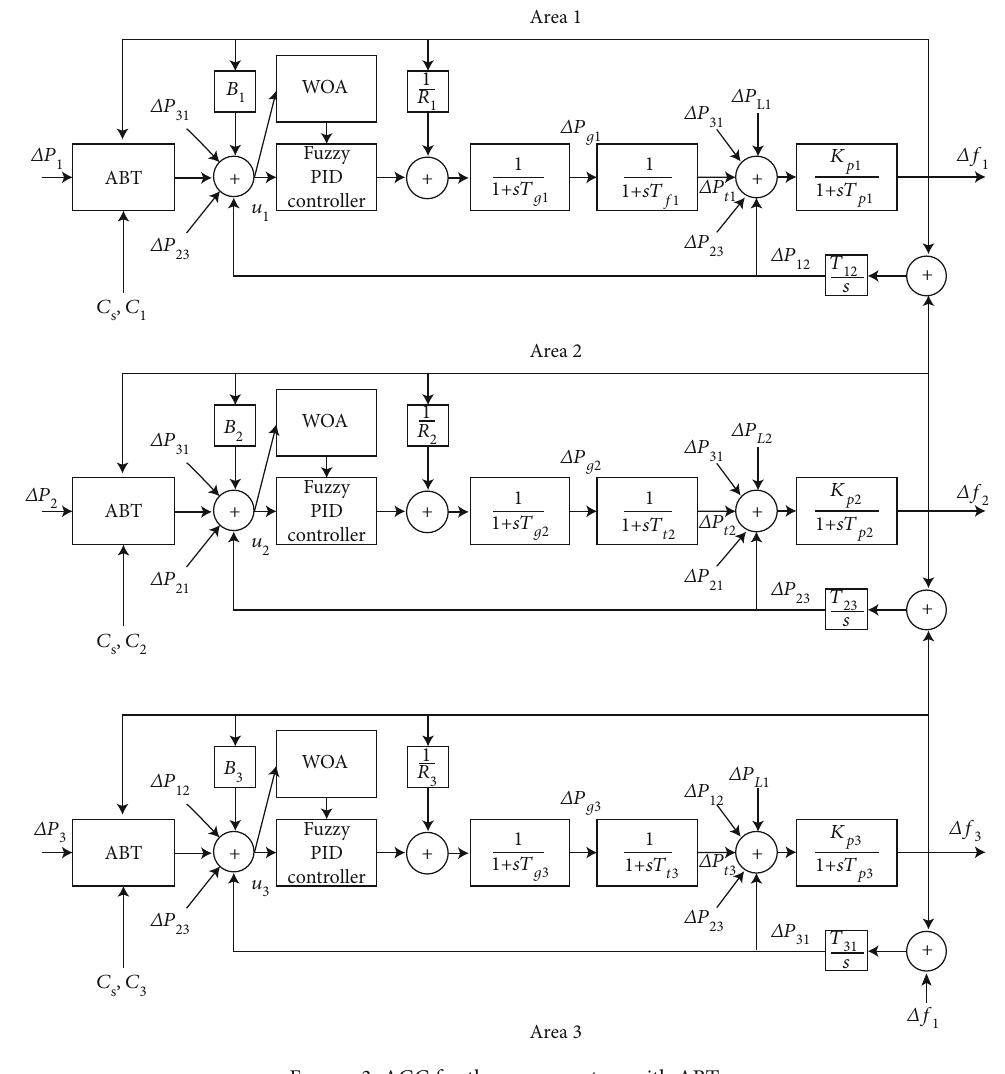
Figure 3: AGC for three-area system with